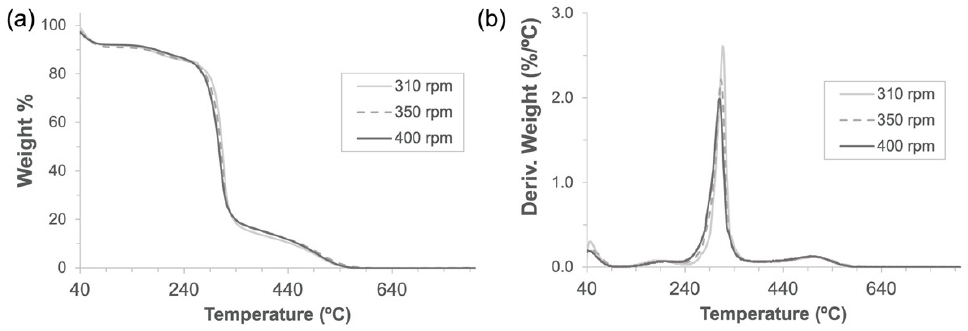
Figure 3. Thermogravimetric analyses ( a ) and their derivatives ( b ) of α -CD-NS obtained through 3 h of mechanochemical (ball mill) synthesis at 310, 350, and 400 rpm using a 500 mL zirconia jar.